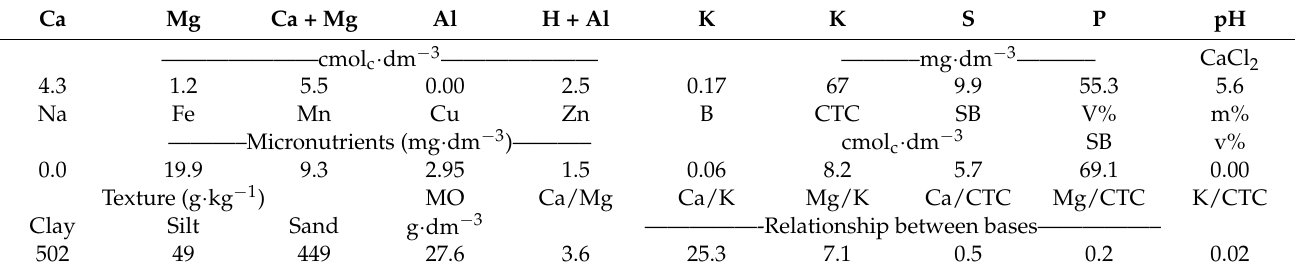
Table 1. Physicochemical characteristics of the Latossolo Vermelho Distrof é rrico soil used in the